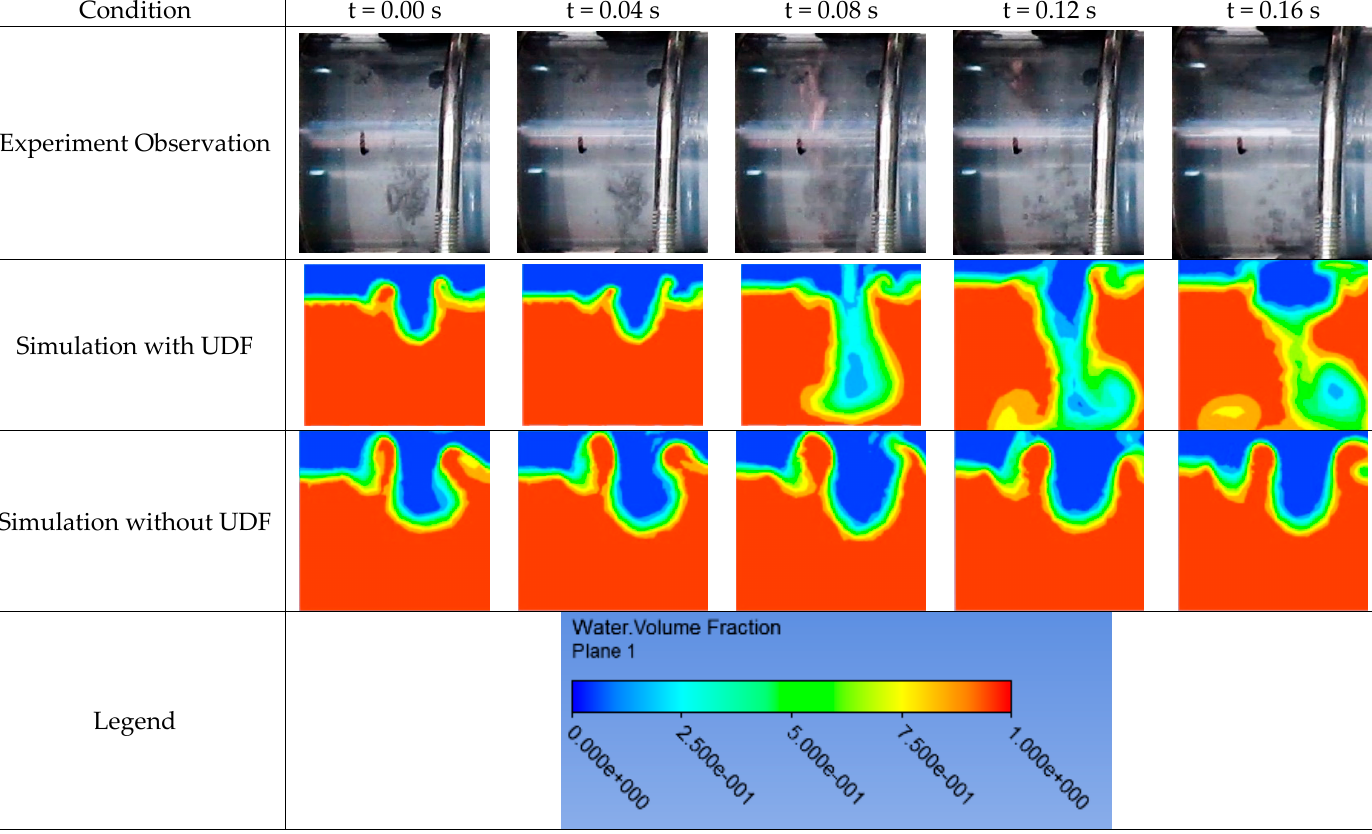
Figure 14. Comparison of experimental observations and volume fractions of water, as simulated by ANSYS Fluent with and without a UDF, at an inlet momentum of 1000 Pa.